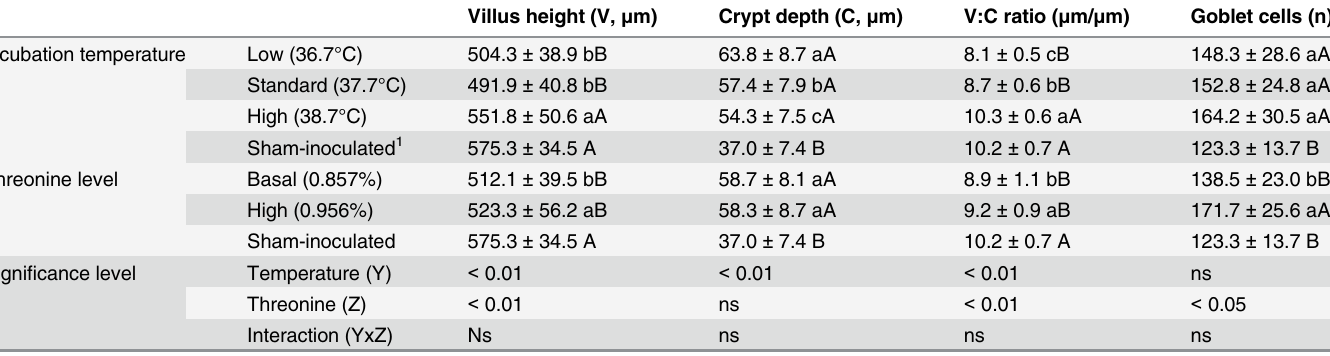
Table 3. Ileum morphology (n = 120 per treatment) and goblet cell counts (n = 12 per treatment) of chicks submitted to thermal manipulation during incubation and fed different threonine levels